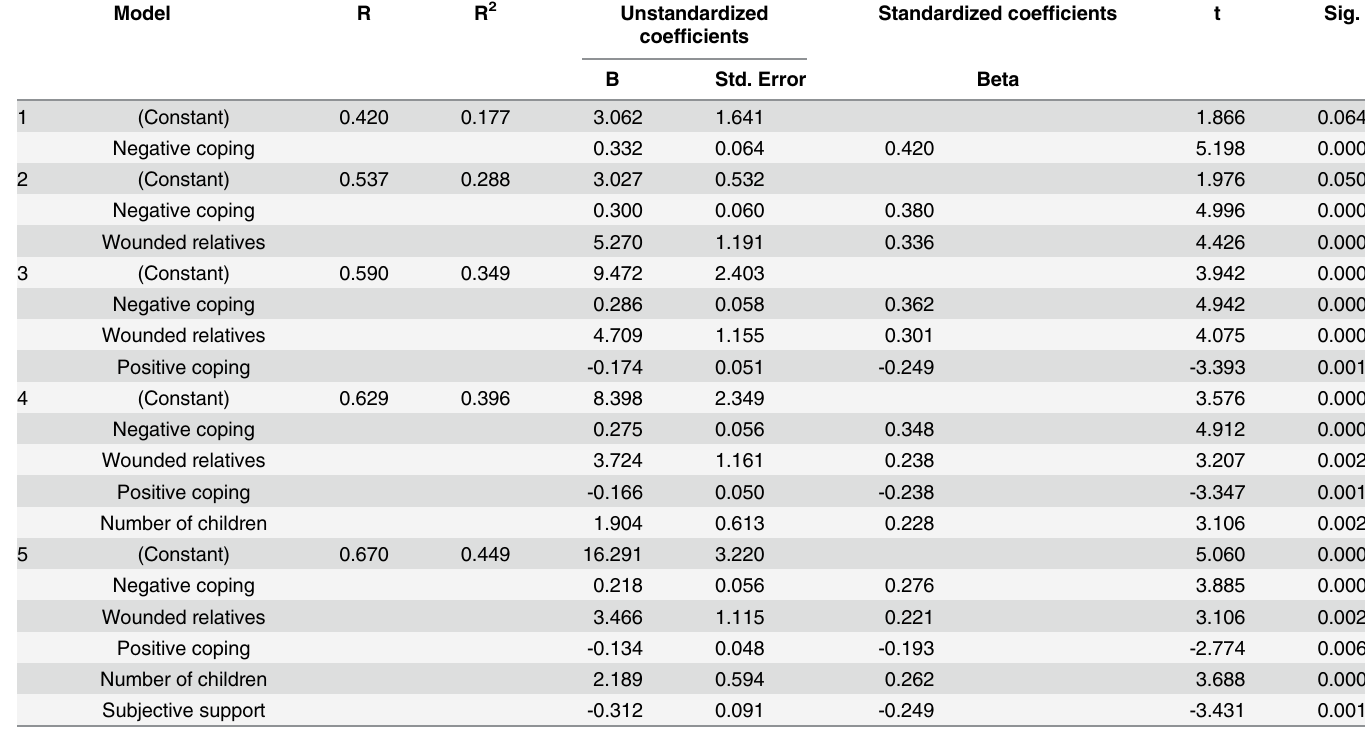
Table 5. Multivariate linear regression analysis against EPDS